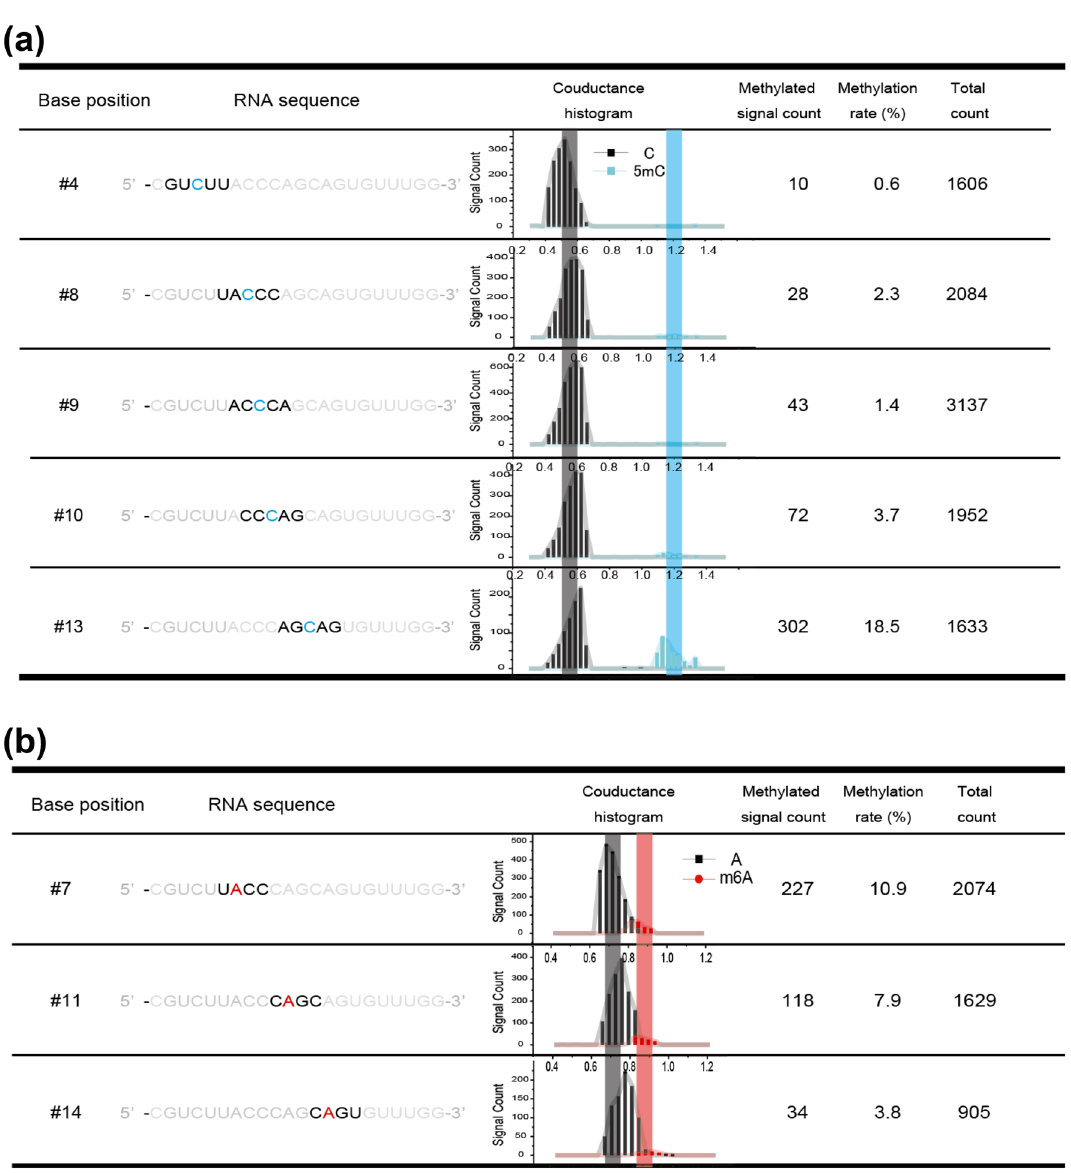
Figure 3. m6A and 5mC counts for single-molecule methylated miR-200c-5p. ( a ) 5mC modification rates in miR-200c-5p. In the second column, the sequences neighboring the methylated cytosines are shown. In the third column, the conductance histograms relative to those of guanine are shown. The black and blue lines represent the typical relative conductance values for C and 5mC, respectively (Table 1). ( b ) m6A modification rates in miR-200c-5p. In the second column, the sequences neighboring the methylated adenosines are shown. In the third column, the conductance histograms relative to those of adenosine are shown. The black and red lines represent the typical relative conductance values for A and m6A, respectively (Table